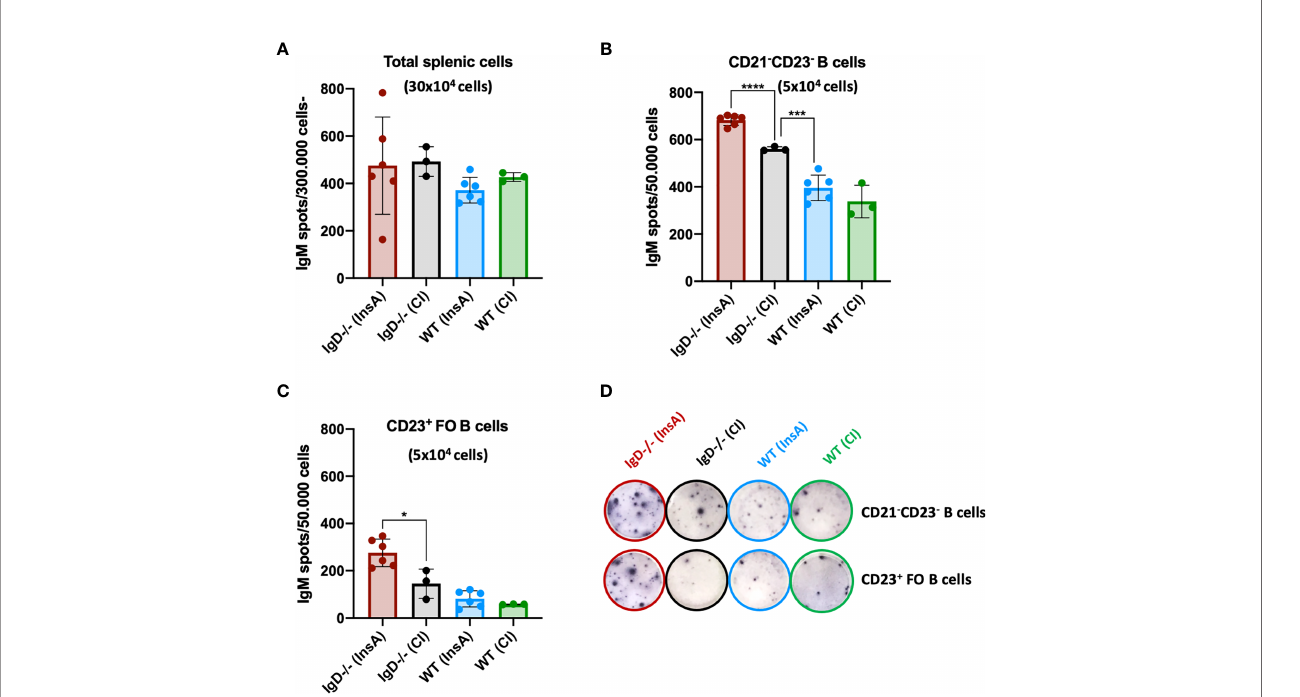
FIGURE 6 | The CD21 - CD23 - B cell population is the major source of IgM-secreting cells under the control of the IgD-class BCR. (A – D) ELISpot analyses showing IgM secreting splenic cells of InsA-KLH + CpG ODN1826 or control (CpG ODN1826) immunized (CI) mice 24 hours after injection. IgM secretion by (A) total splenic cells, (B) CD21 - CD23 - sorted B cells, (C) CD23 + follicular B cells, (D) representative images of ELISpot wells of indicated cell numbers, genotypes and immunizations. Two independent experiments with n=3/group for CI and n=6/group for InsA-KLH were performed. Mean, ± SD, students t-tests with Welch ’ s correction was used to compare two groups within one experiment. *P < 0.05, ***P < 0.001, ****P <